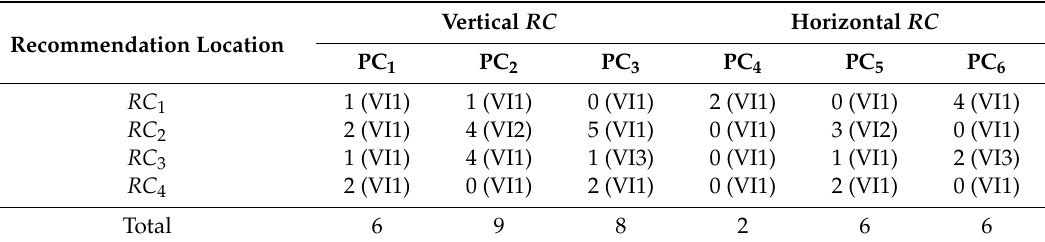
Table 2. Recommendation driven purchase and visual intensity for each recommendation location ( RC i ) and product category ( PC j